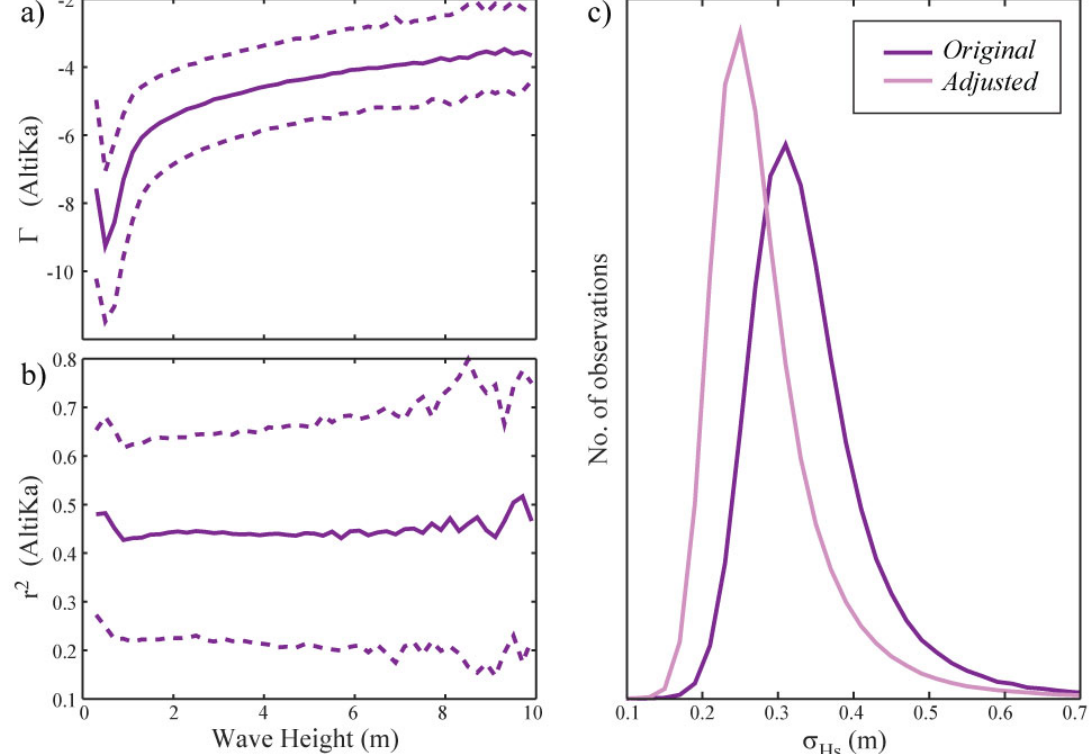
Figure 8. Analysis of covariant errors for AltiKa. ( a ) Variation of sensitivity parameter, Γ as a function of Hs. Lines from bottom up show 5th, 50th, and 95th percentiles. ( b ) Same for r 2 (fraction of variance explained) ( c ) Variability in 1 Hz record of original Hs data, and that adjusted using a value of Γ of −